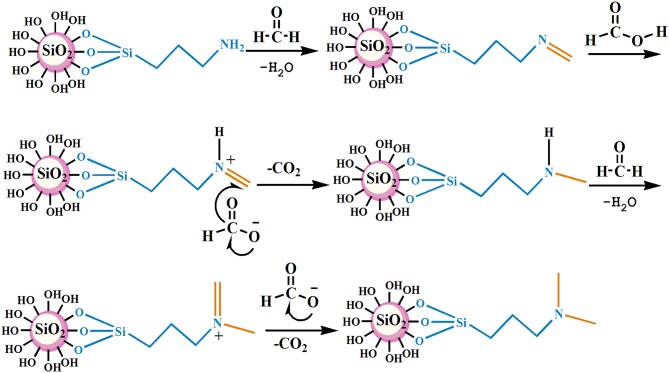
Schematic of the reaction steps of NS–NR2.